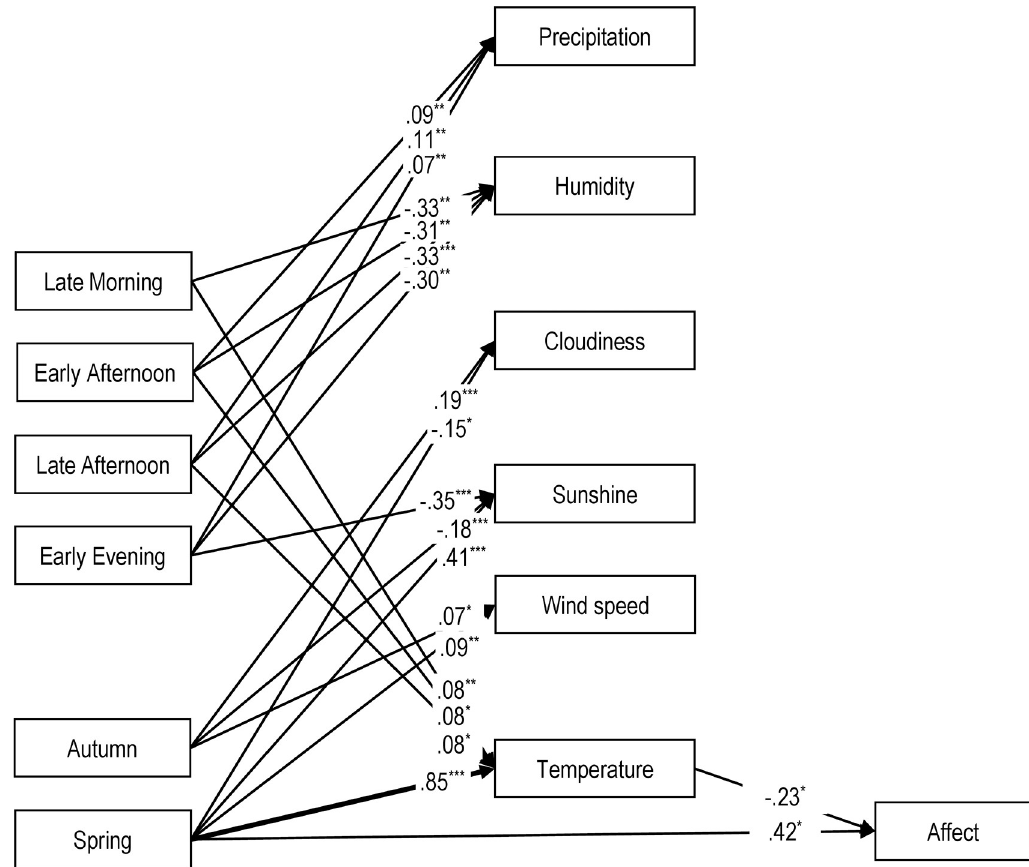
Fig 2. Path model for role of seasons and weather conditions in affective valence. Note . The figure presents only significant paths for the tested path model. For clarity, all non-significant paths from the model were omitted. Thicker lines represent stronger effects. Sex coded as 0 = men, 1 = women. � p < .05, �� p < .01, ��� p <